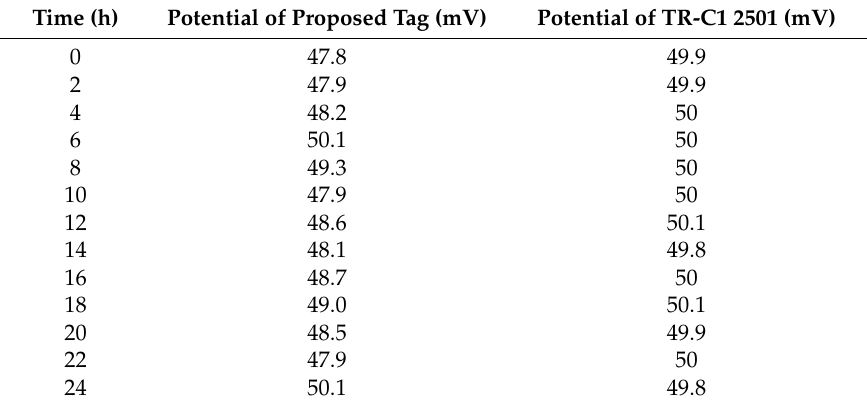
Table 4. Results of measured potential.